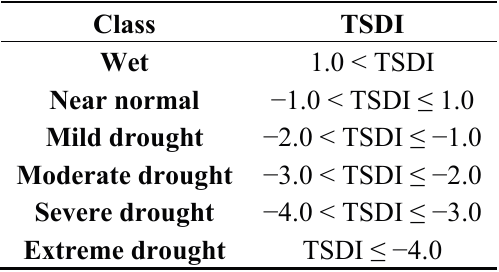
Table 3. Drought severity classification based on TSDI.